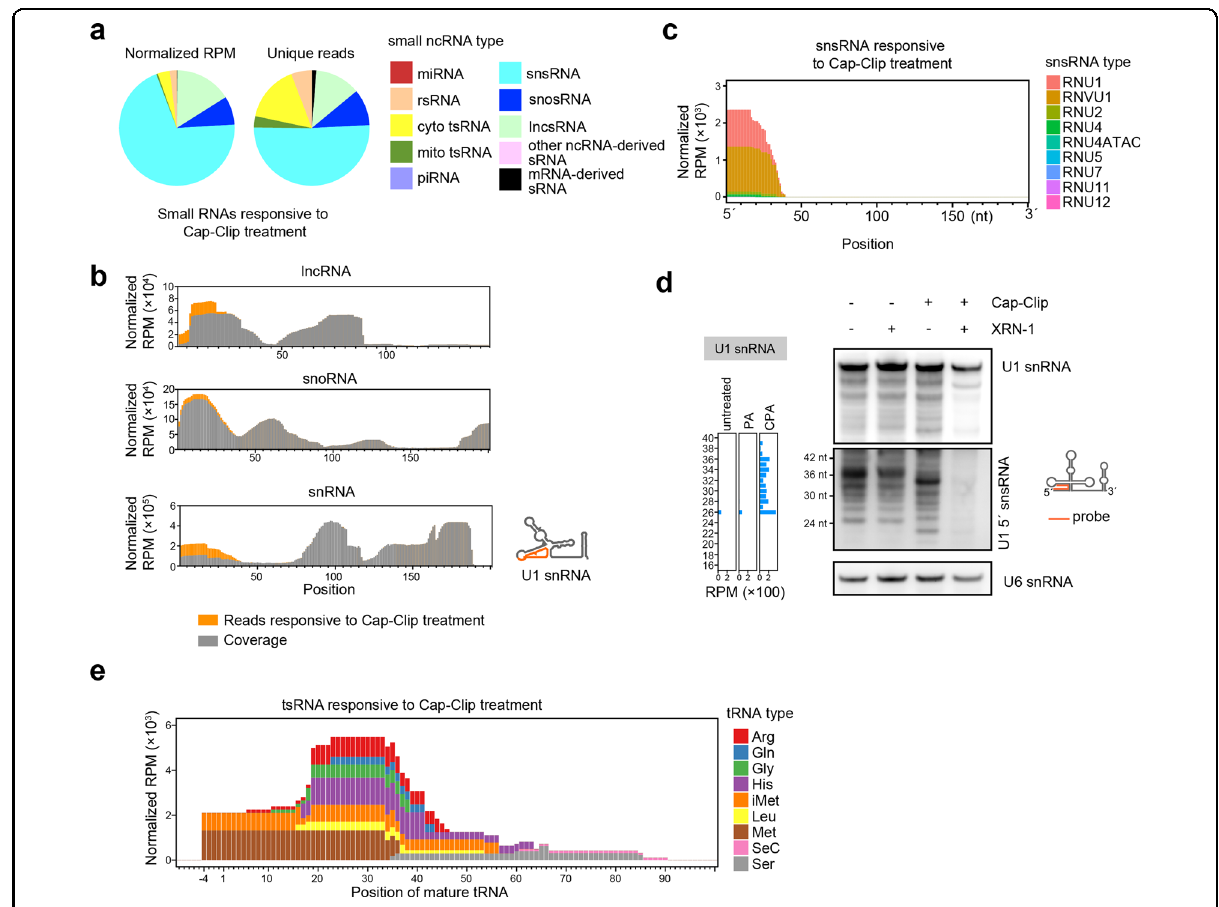
Fig. 3 CPA-seq reveals sRNAs with 5 ′ -cap and 5 ′ -ppp. a Distribution of different types of sRNAs responsive to Cap-Clip treatment (unique reads that were highly detected in CPA group, but lowly detected in PA group with the fold change >30, n = 2). b Reads of sRNA responsive to Cap-Clip treatment mapping to lncRNAs, snoRNAs, and snRNAs have been combined to show the detection of lncsRNAs, snosRNAs, and snsRNAs putatively containing 5 ′ -caps or 5 ′ -ppp. c Reads of snsRNAs responsive to Cap-Clip treatments. d Northern blotting of sRNAs treated with the indicated enzymes, using a probe complementary to U1-5 ′ snsRNA. Cap-Clip removed the 5 ′ -cap from U1-5 ′ snsRNAs and enabled U1-5 ′ snsRNAs to be digested by XRN-1 (lane 4), a 5 ′ → 3 ′ exoribonuclease that requires 5 ′ -P. Removal of the 5 ′ -cap by Cap-Clip leads to a slight shift of the bands representing U1-5 ′ snsRNAs (lane 3). U6 snRNA is used as a reference. e Reads of tsRNAs responsive to Cap-Clip